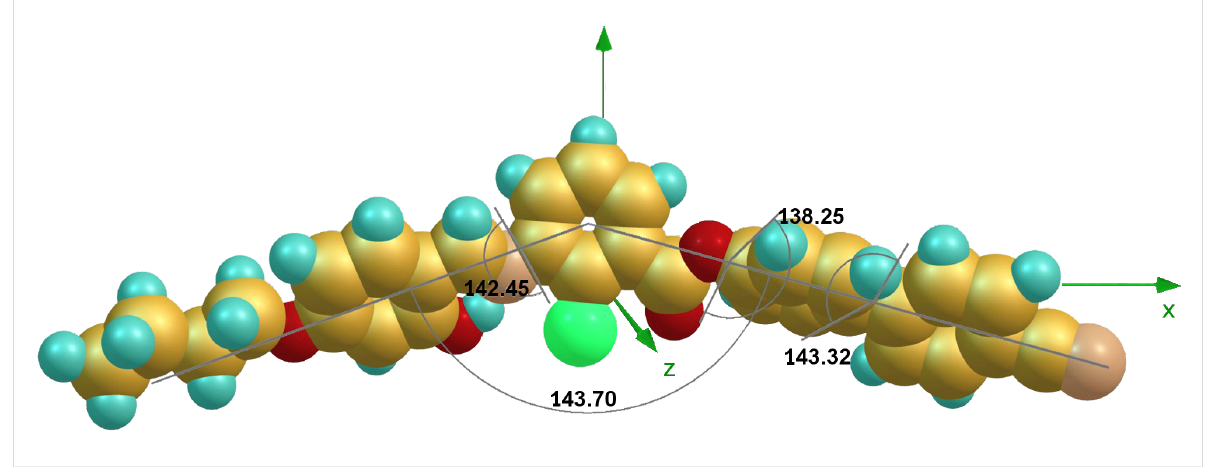
Figure 3: Molecular structure of 1a optimized at the DFT level. The bent angle is 143°, and the three dihedral angles indicated the out-of plane adja- cent phenyl rings.